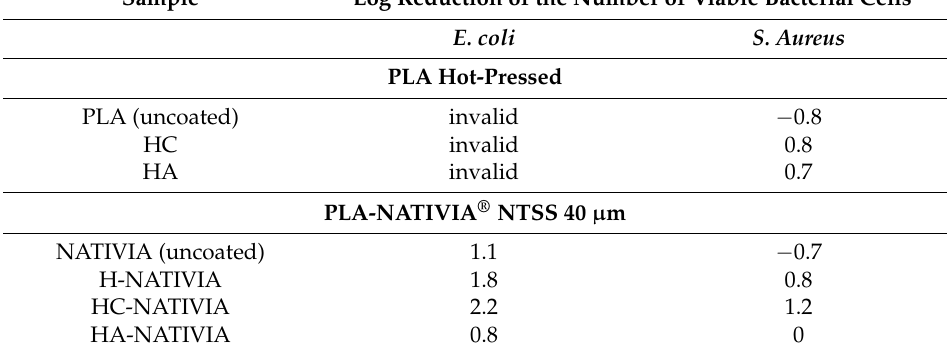
Table 3. Results of the antibacterial tests performed according to ISO 22196:2007 (E) (only the upper face was treated).